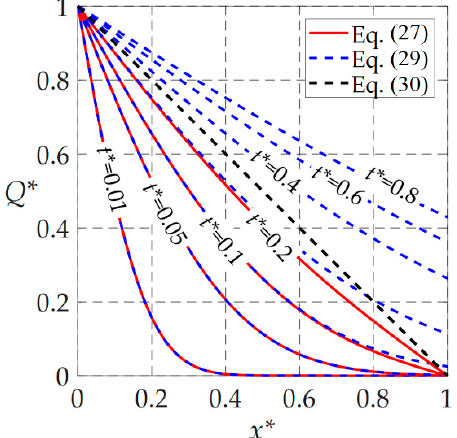
Figure 7. Dimensionless longshore-sediment-transport rate Q*.